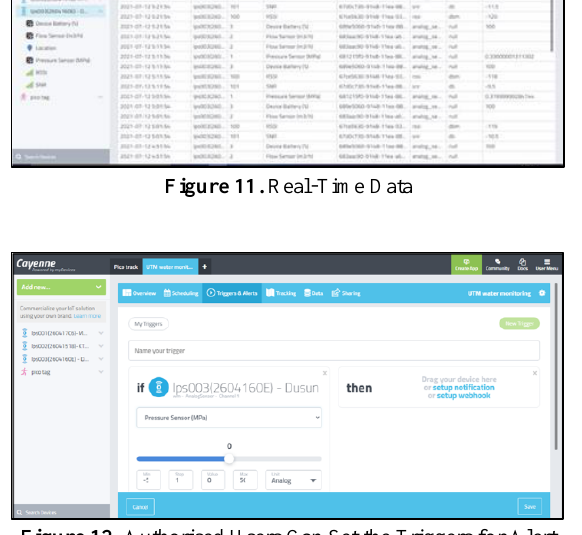
Figure 12. Authorised Users Can Set the Triggers for Alert